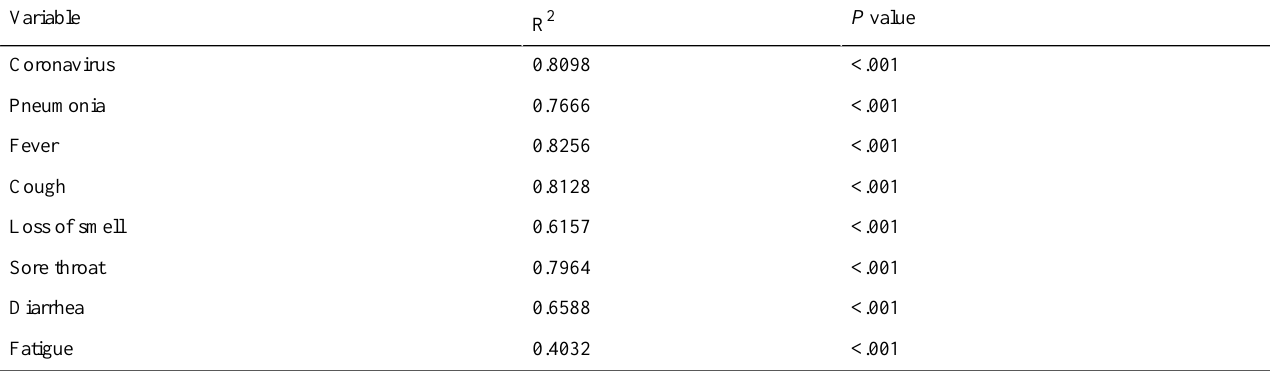
Table 5. Coefficients of determination between the number of new polymerase chain reaction-confirmed COVID-19 cases per day and the search variables in Google Trends with a critical level of significance ( P